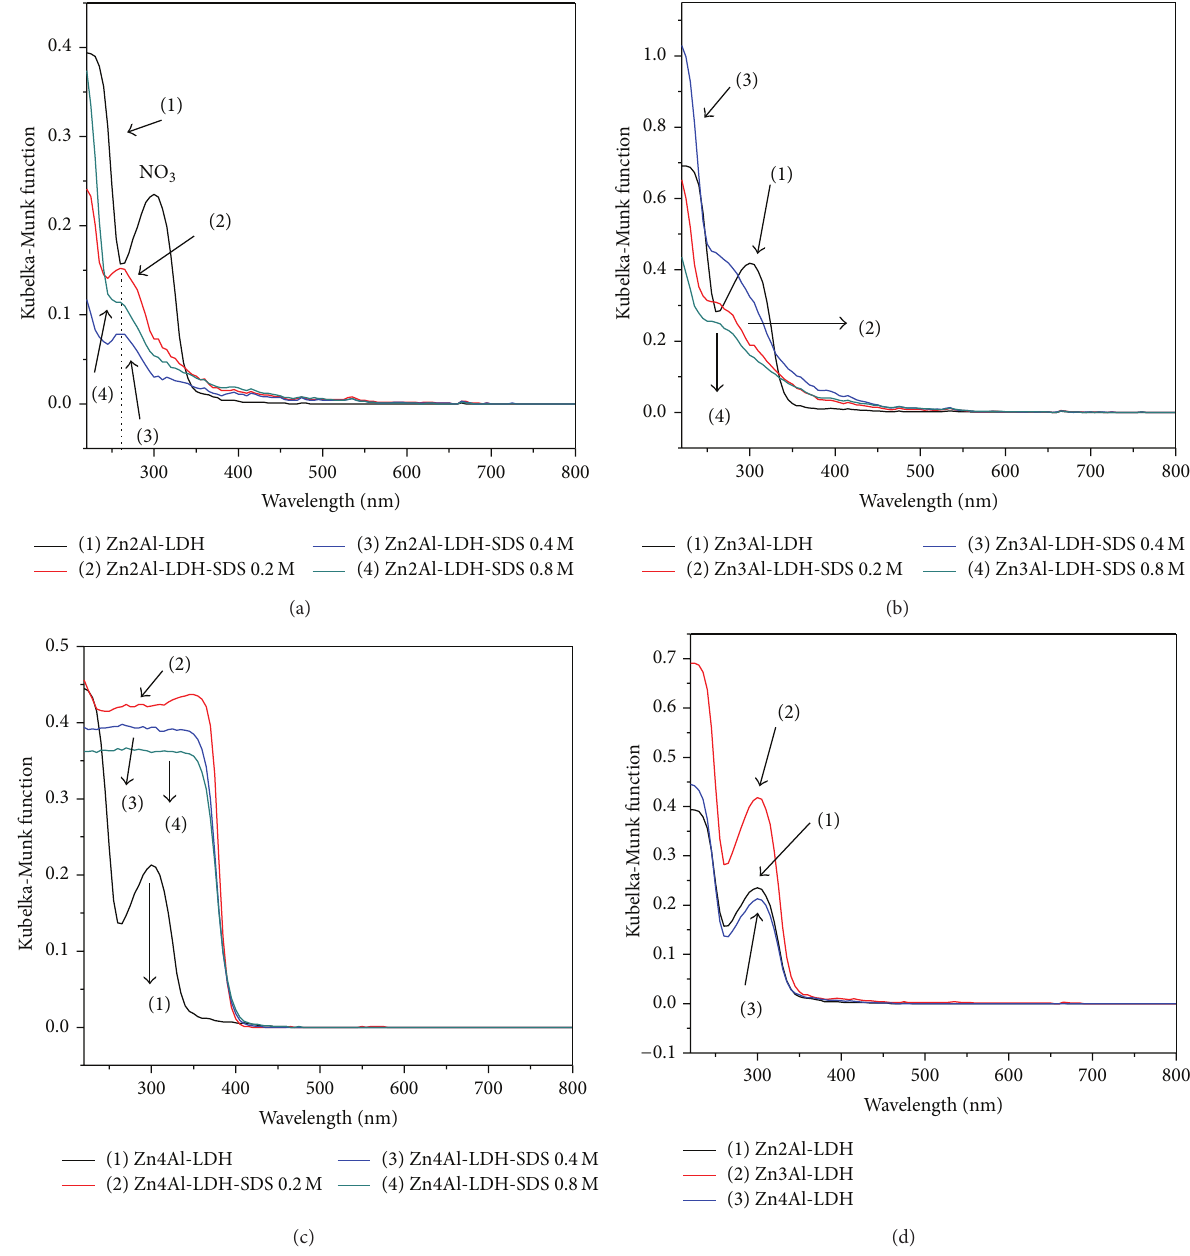
Figure 6: Diffuse reflectance UV-visible absorption spectra of Zn 𝑟 Al–NO 3 –LDH and LDH-SDS in different